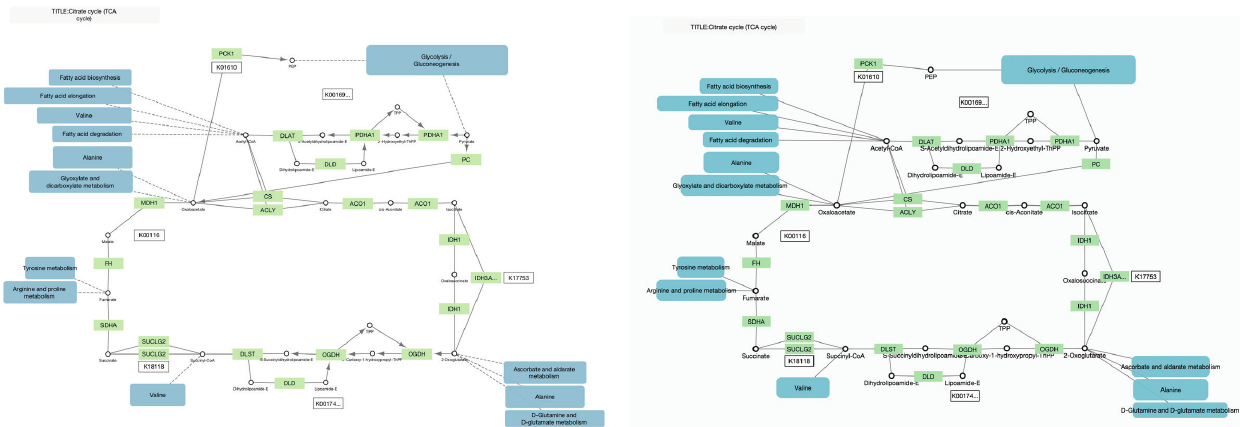
Figure 5. Original network view in Cytoscape 3.1 (left) and same data exported as JSON file and visualized by the template code using Cytoscape.js (right). Original network data was imported to Cytoscape 3 using the KEGGScape app. Cytoscape.js version